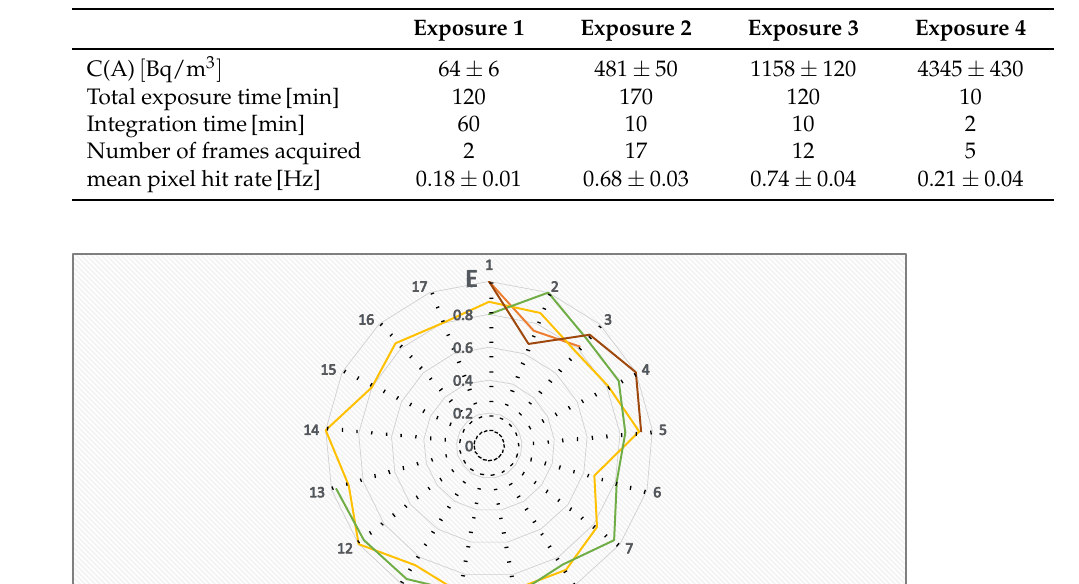
Table 1. Exposure run parameters used for the TimePix characterisation at INMRI radon facility. The average radon activity concentration C(A) values in Bq/m 3 were measured using the calibrated ALPHAGuard monitor. The TimePix parameters set for the different exposures are reported below the radon activity concentration values.